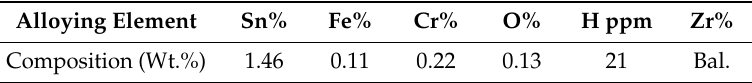
Table 2. The composition of Zr-4 alloy. Alloying Element Sn% Fe% Cr% O% Composition (Wt.%)